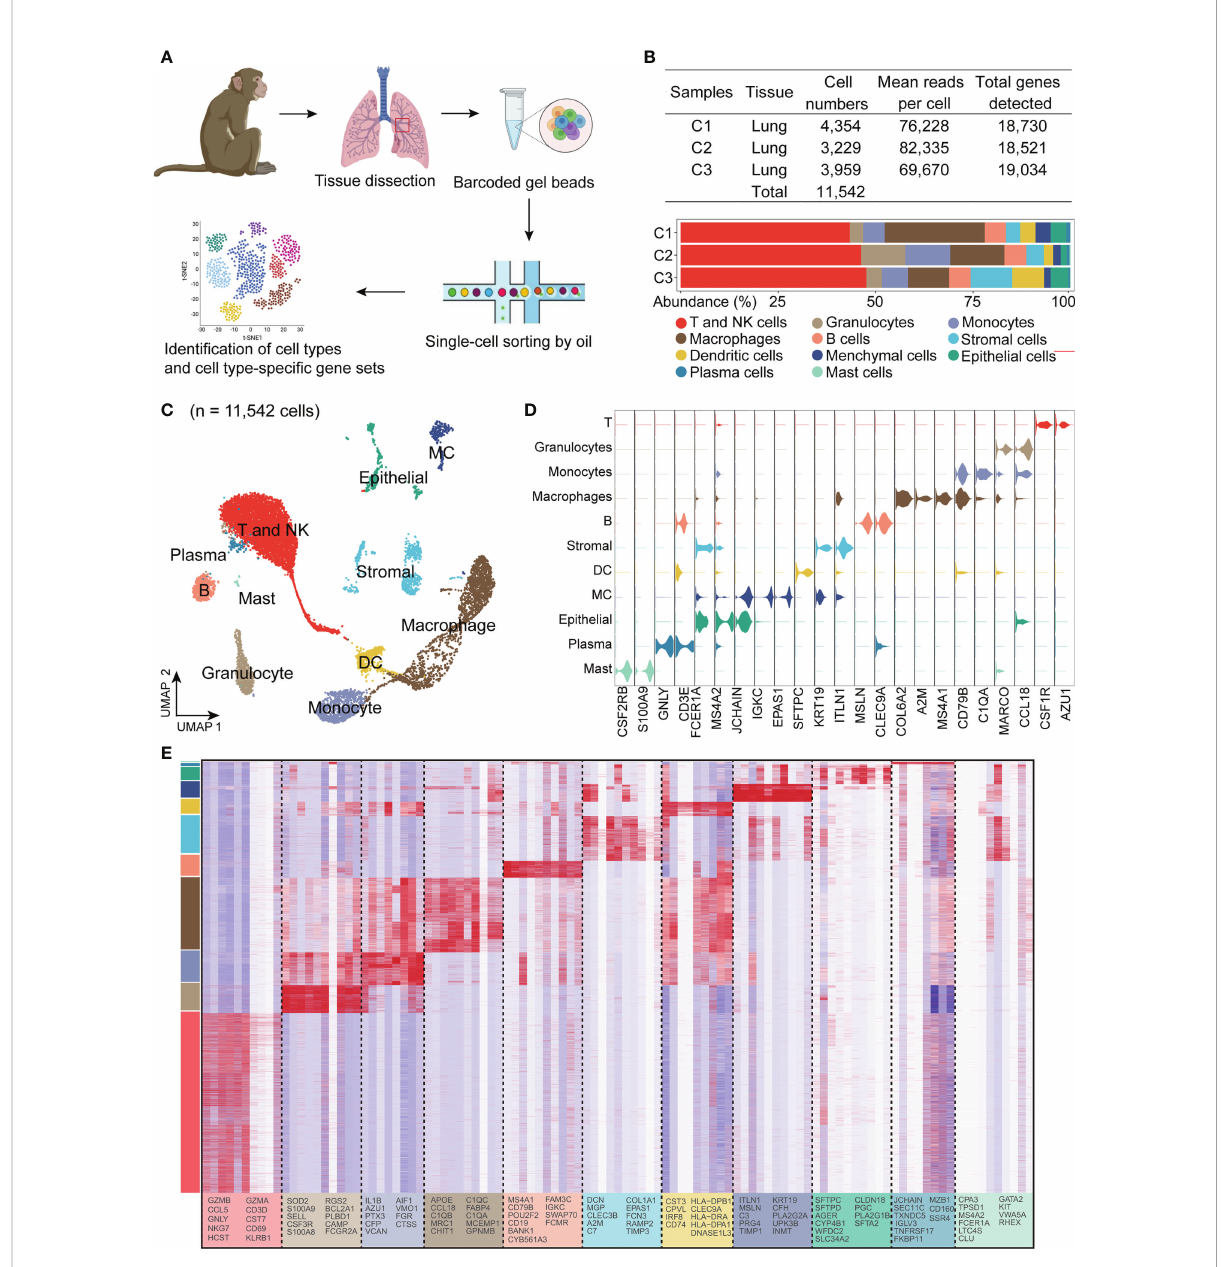
FIGURE 1 Single-cell RNA-seq identi fi es eleven major cell clusters in the lungs in healthy cynomolgus monkeys. (A) , Experimental design and analysis of single cells from monkey lung samples. The red rectangle indicates an approximate region of sample collection. (B) , Table with the details of sample information and representation of major cell subsets as a function of total cells for each sample. (C) , Uniform manifold approximation and projection (UMAP) of 11,542 cells from the lungs colored by 11 major cell types based on signature gene expression. (D) , Violin plots of unique genes expression speci fi cally distinguishes each cluster (T and NK) (GNLY and CD3E), granulocyte (CSF2RB and S100A9), monocytes (CSF1R, AZU1 and S100A9), macrophage (C1QA, MARCO and Ccl18), B cells (MS4A1 and CD79B), stromal cells (COL6A2 and A2M), dendritic cells (DC) (CLEC9A), mesenchymal cells (MC) (UPK3B, MSLN and ITLN1), epithelial cells (EPAS1, SFTPC and SFTPD), plasma cells (JCHAIN and IGKC) and mast cells (FCER1A and MS4A2), respectively. (E) , Heatmap showing row-scaled expression of the ten highest DEGs for all QC-passed cells colored by cell